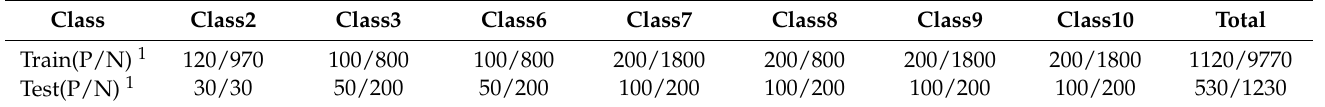
Table 1. The image distribution of each class.